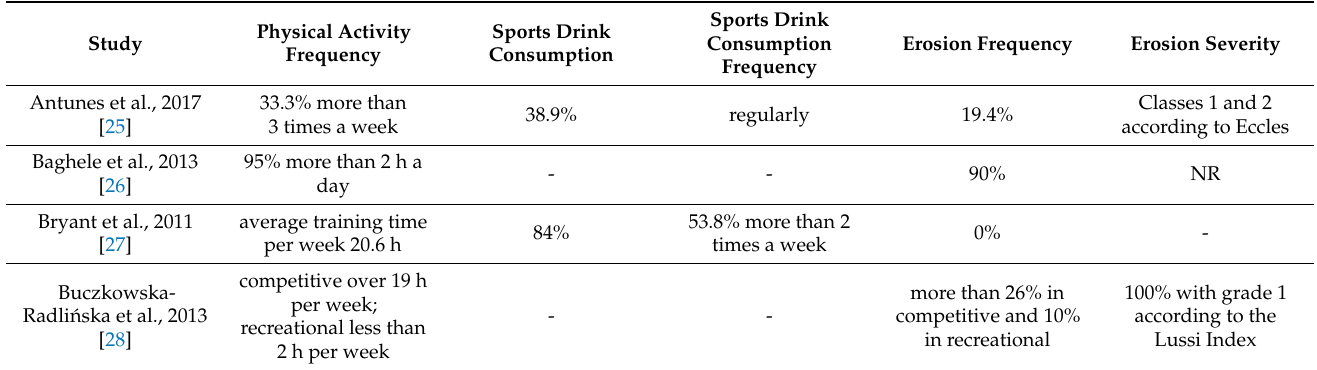
Table 3. Detailed characteristics of included studies considering potential impact of physical activity and sports drink consumption on dental